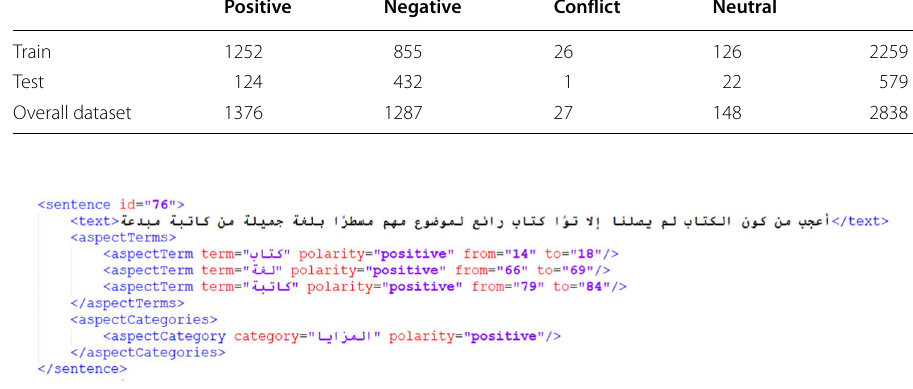
Fig. 2 Example of the HAAD dataset schema